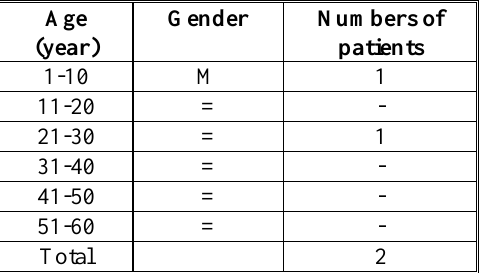
Table (4 ) Age distribution of anti H.pylori IgA positive serum samples in males